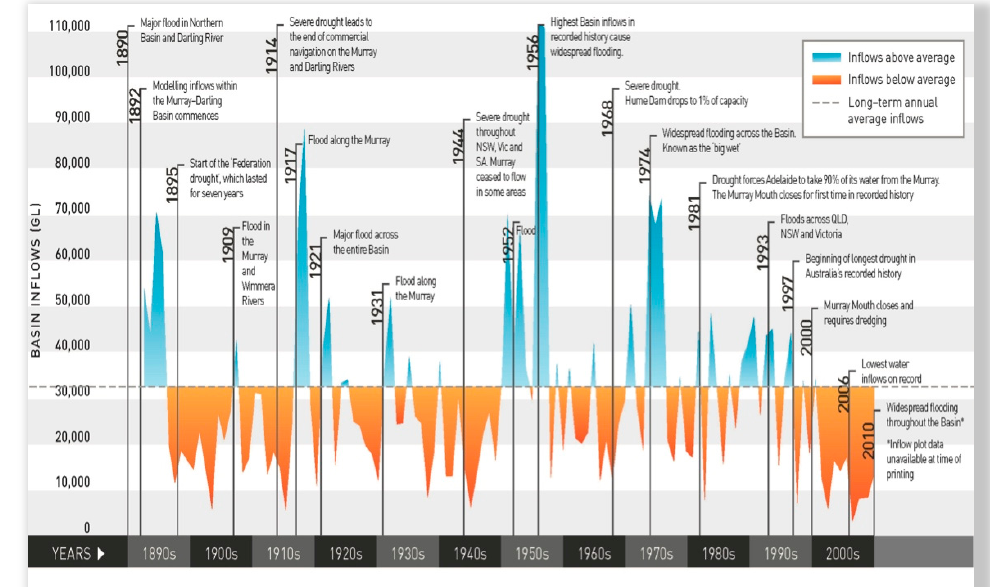
Figure 2. River inflows for the Murray Darling Basin [86].